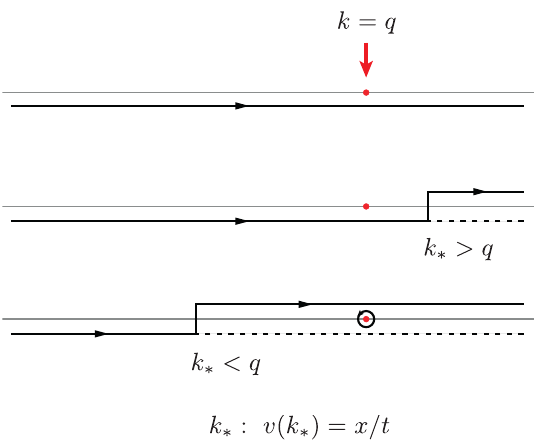
Figure 11: Complex analysis method for the derivation of the asymptotics of the